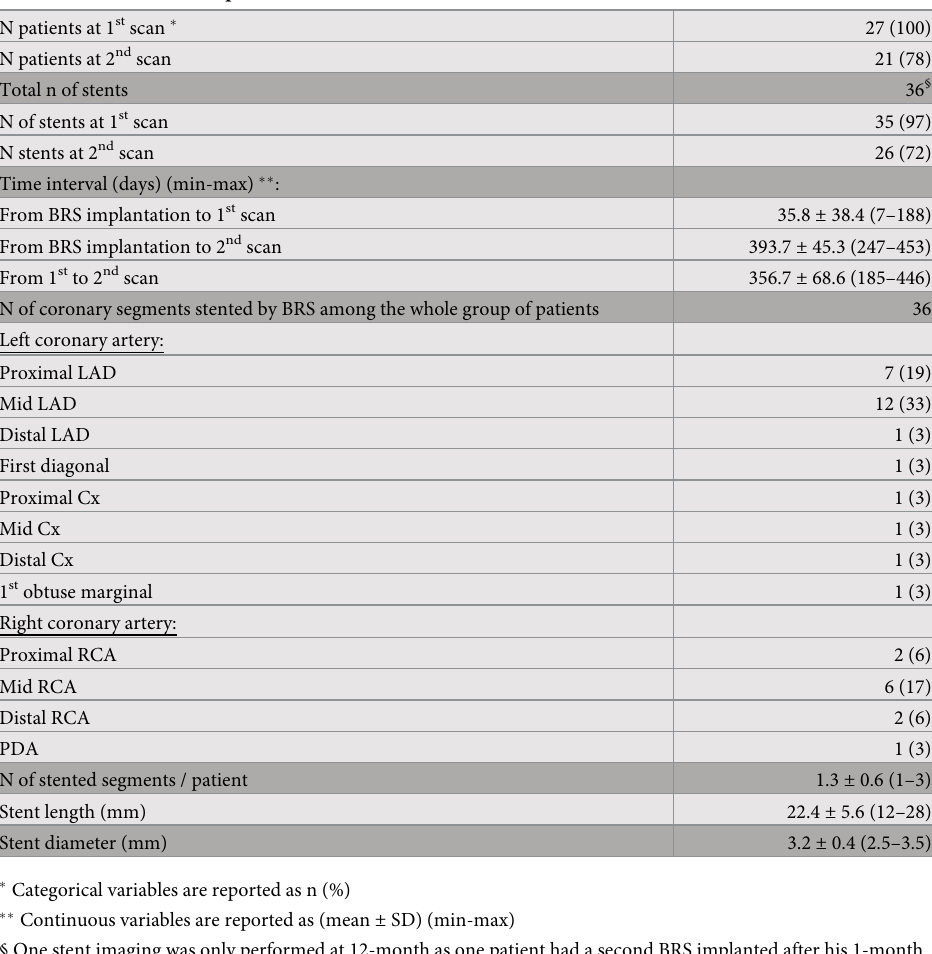
Table 1. Stent distribution parameters. N patients at 1 st scan